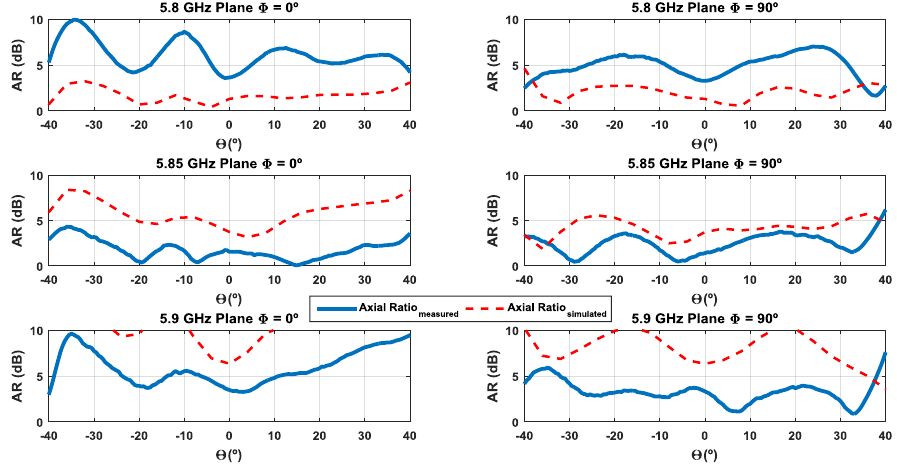
Figure 16. Simulated and measured axial ratio of the antenna over the mainlobe.